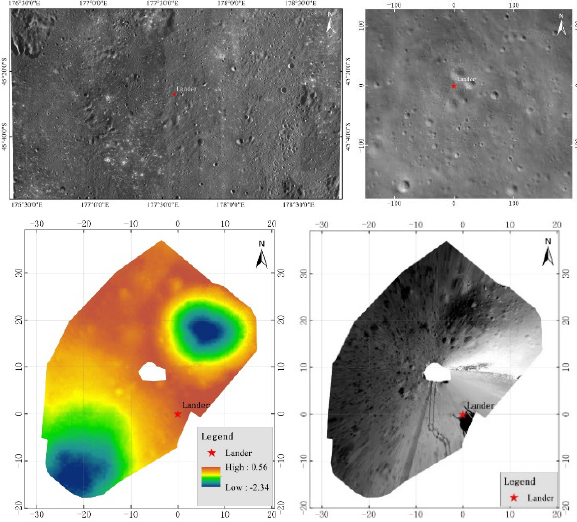
Figure 2. Topographic maps of CE-4 landig site of different scales (Liu et al., 2020). Upper left: LROC NAC